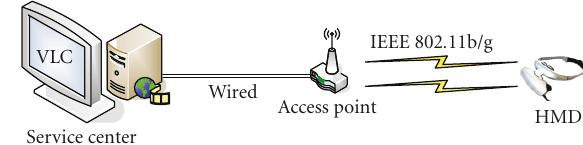
Figure 1: A Simple system